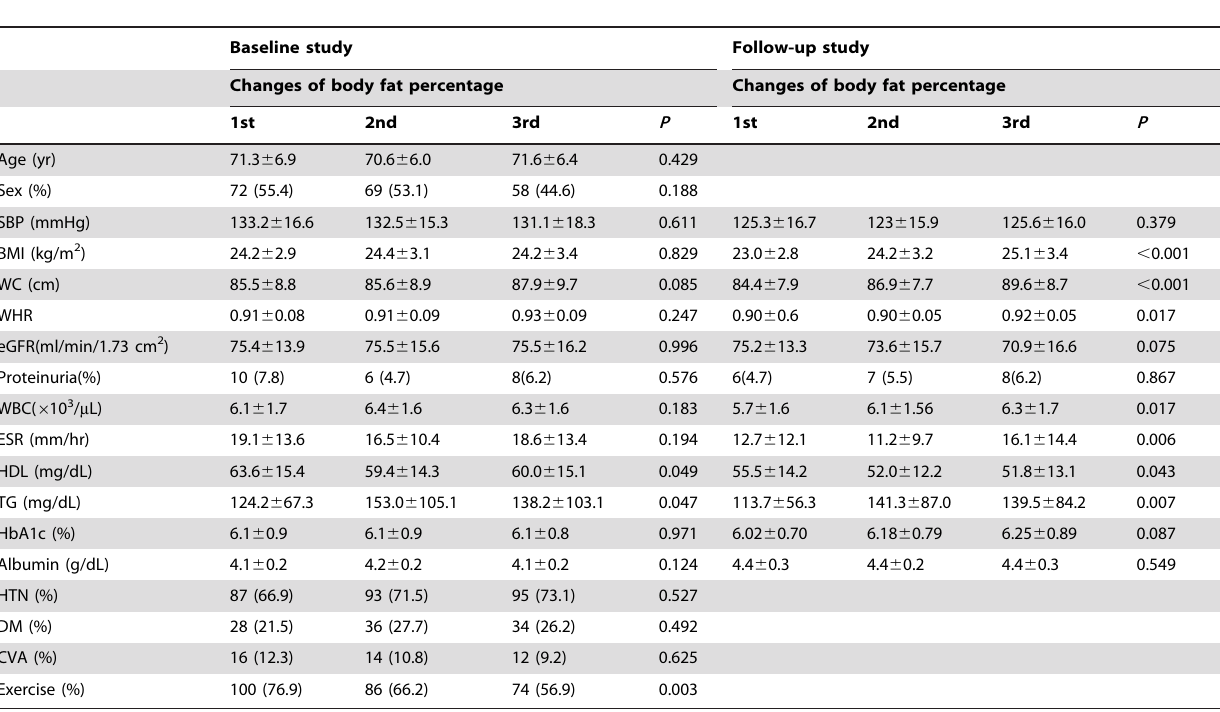
Table 2. Clinical parameters of baseline and follow-up according to the change of body fat percentage.